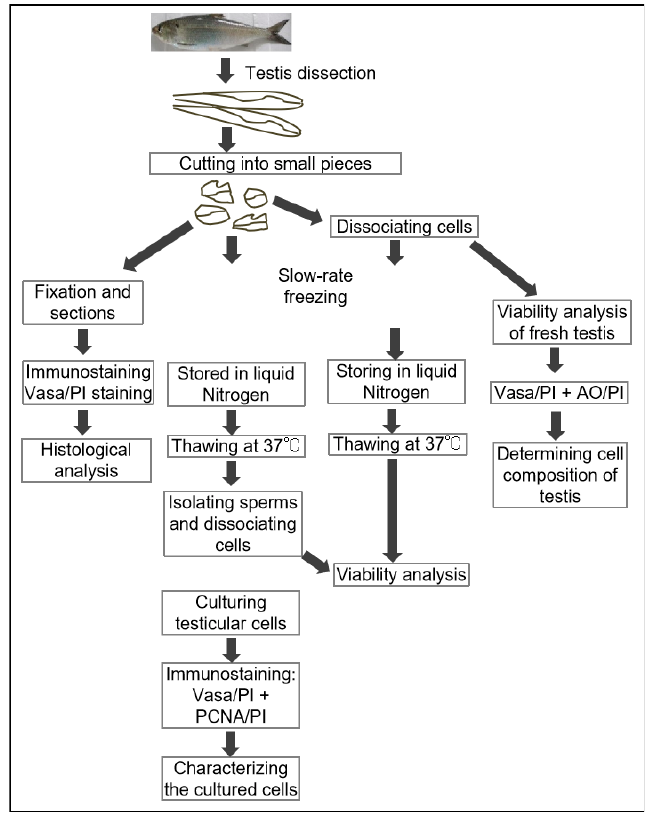
Figure 1. The flowchart of experiments. In total, 19 fish were used in this study, including 4 American shad fish that were 7 months in age (weighted 250.0–300.0 g), and 8 that were 24-months old (weighted 628.0–850.0 g). Moreover, a group of three male American shad fish that were 15-months old (weighted 550.0–625.0 g) and 4 adult Asian seabass ( Lates calcarifer ) (4-year-old, weighted 3.5~4.2 kg) were used as control groups or method validation. Live fish were immersed in a 0.01% solution of buffered MS-222 until gill movement ceased and there was no response to mechanical stimulation (~10 min). All individuals were rinsed with clean water and the gonads were dissected. All fish testes were dissected and cut into small pieces (edge length of 2~3 mm) for the downstream processes: some of the testis pieces were cryopreserved immediately (5 pieces per tube and 3 tubes per fish); some of pieces were digested to obtain isolated testicular cells for cryopreservation (10 tubes per fish) and cell viability analysis of fresh samples. Two tubes of samples from one fish were analyzed in technical duplicates, and at least three fish were examined for each group or batch. The histological analysis (H&E staining and immunostaining) were conducted in three samples (of fish) per batch. All data are shown in percentages (%) and the mean ± SD in tables, n =